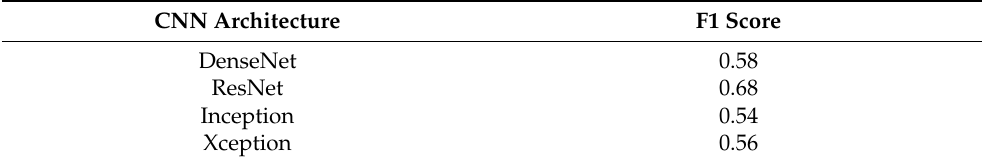
Table 1. F1 scores for the CNN architectures considered. CNN